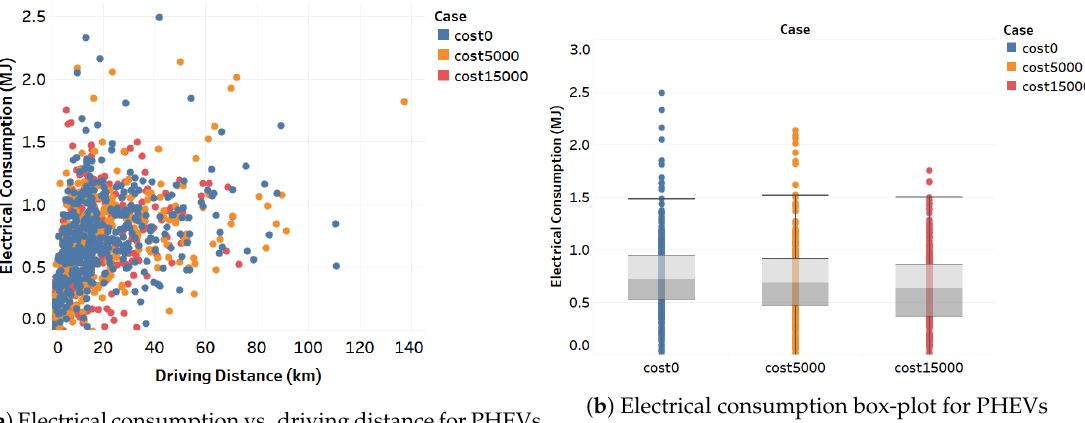
Figure 7. Electrical consumption distribution for